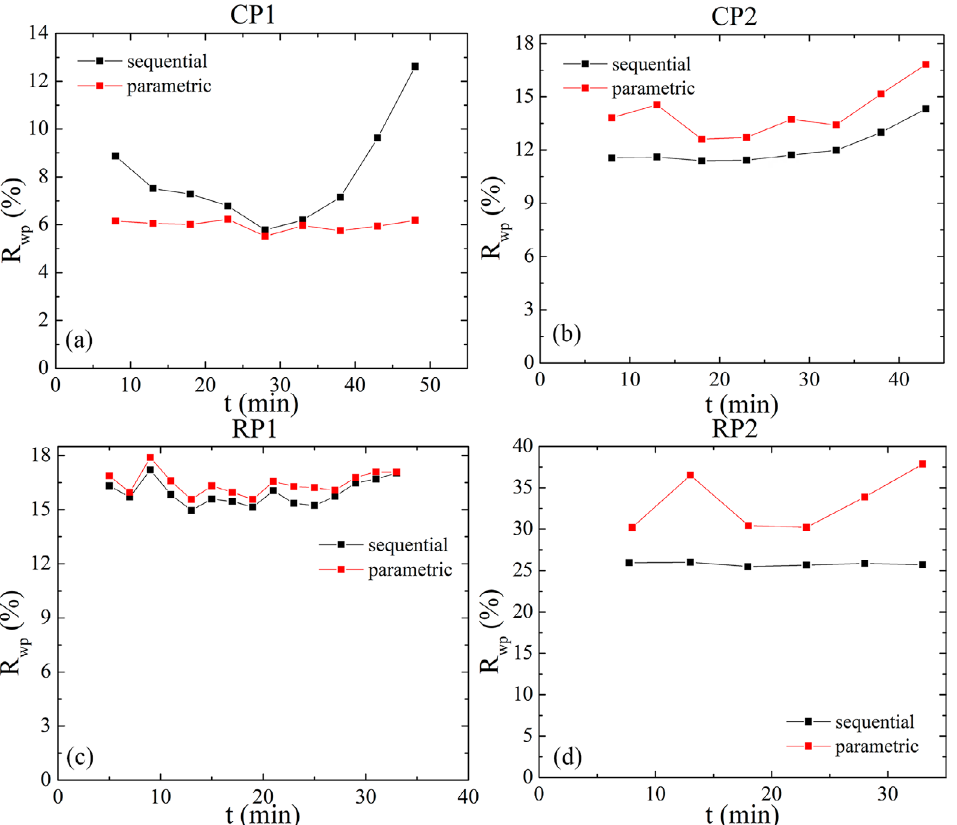
index behavior in the sequential and parametric Rietveld refinements for the samples (a) CP1, (b) CP2, (c) RP1, and (d) RP2. Figure 16. R wp